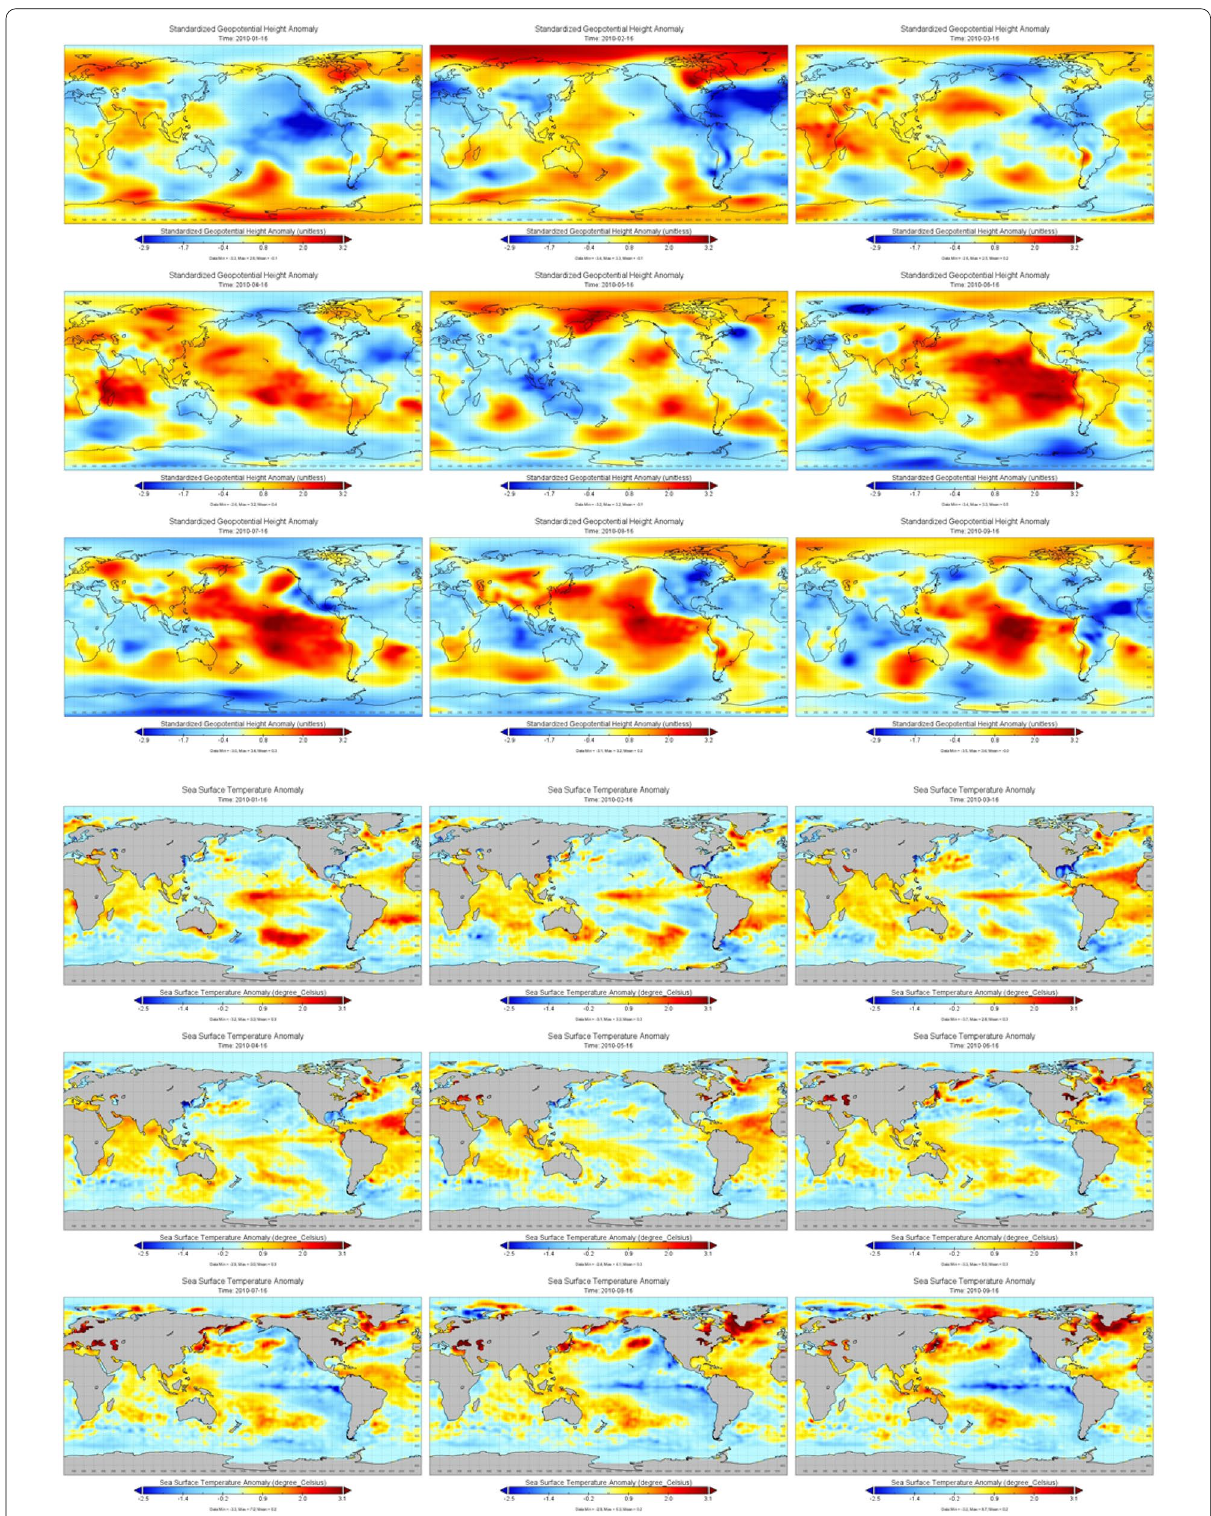
Fig. 18 Global-scale GPH and SST anomaly (January to September